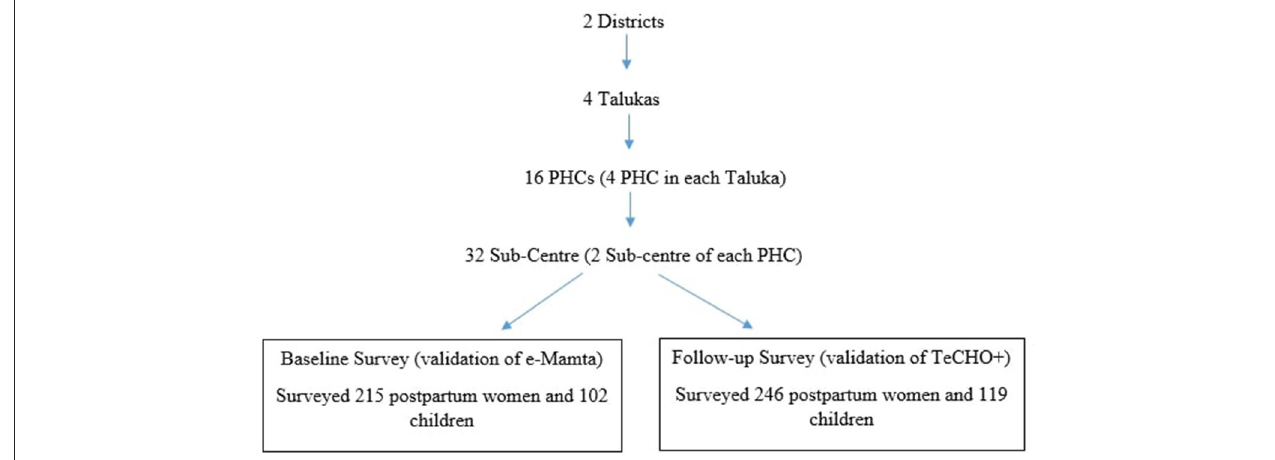
FIGURE 1 | Sampling of the study.